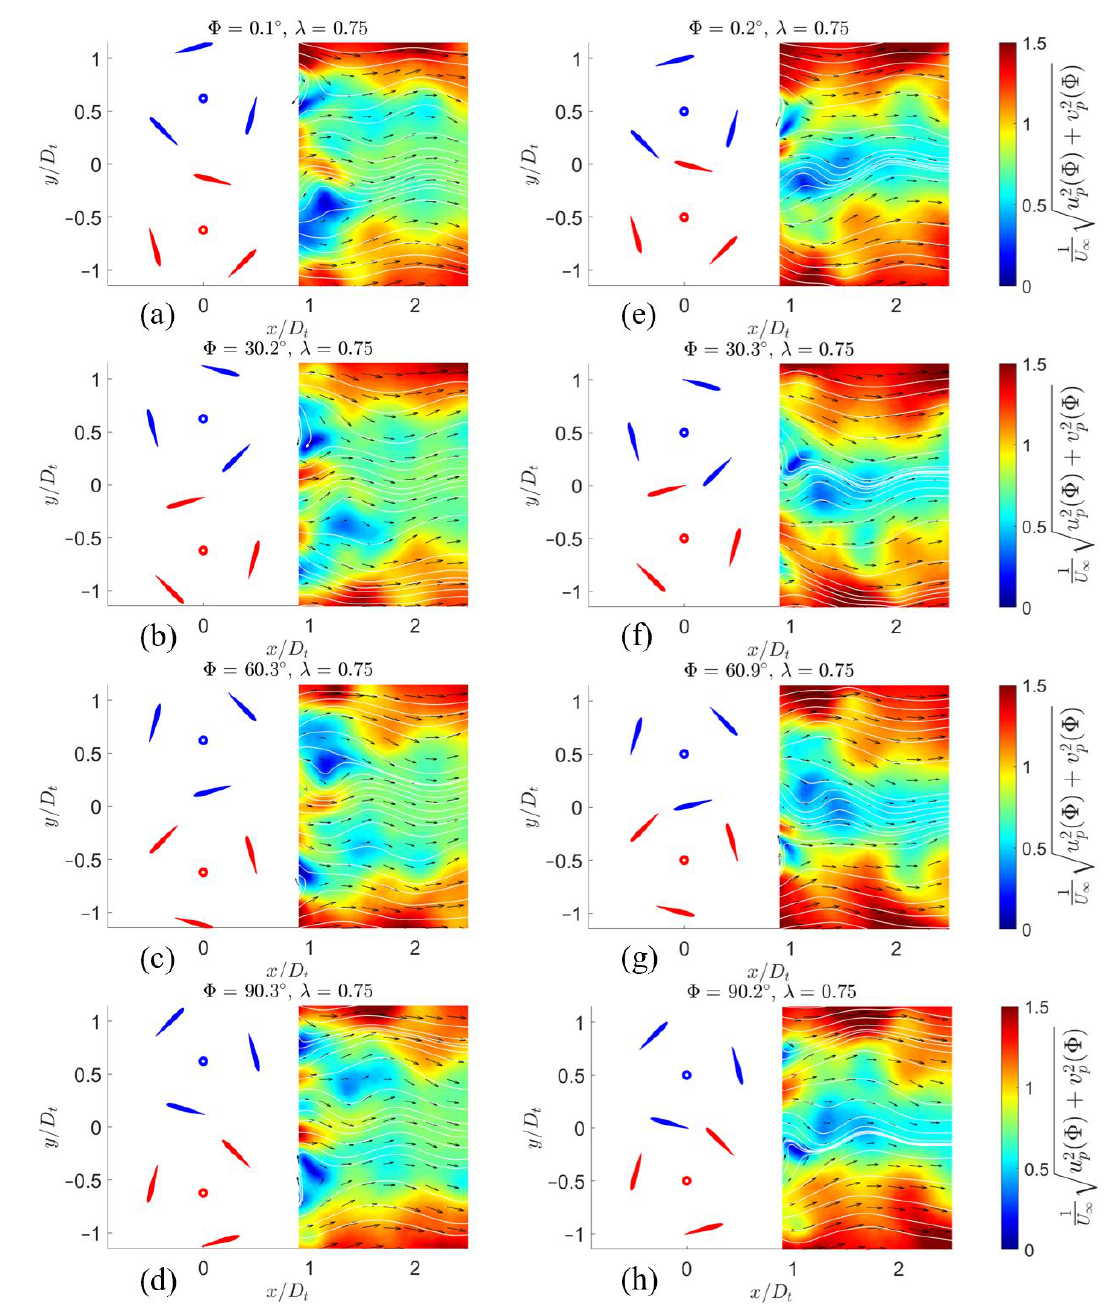
Figure 13. The phase-averaged flow fields behind the backward counter-rotating ( a – d ) and overlapping ( e – h ) configurations at ∆Φ = 60 ◦ and λ = 0.75. The power coefficients of these configurations are 0.097 and 0.092 for forward counter-rotating ( ∆Φ = 60 ◦ ) and overlapping configuration correspondingly. The displayed phase angles Φ belong to turbine T1 in red color. The color shows the non-dimensionalized phase-averaged velocity